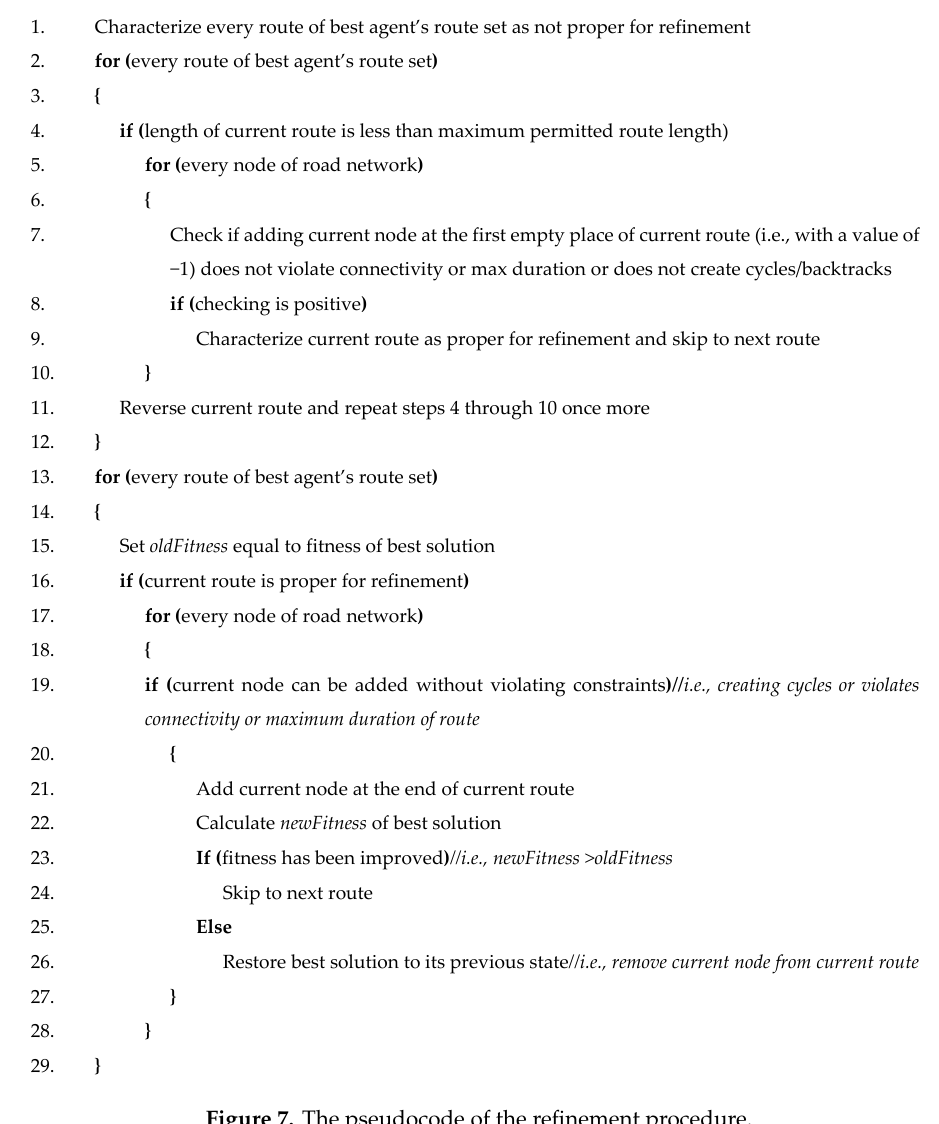
Table 4. Attributes of input instances' road networks.